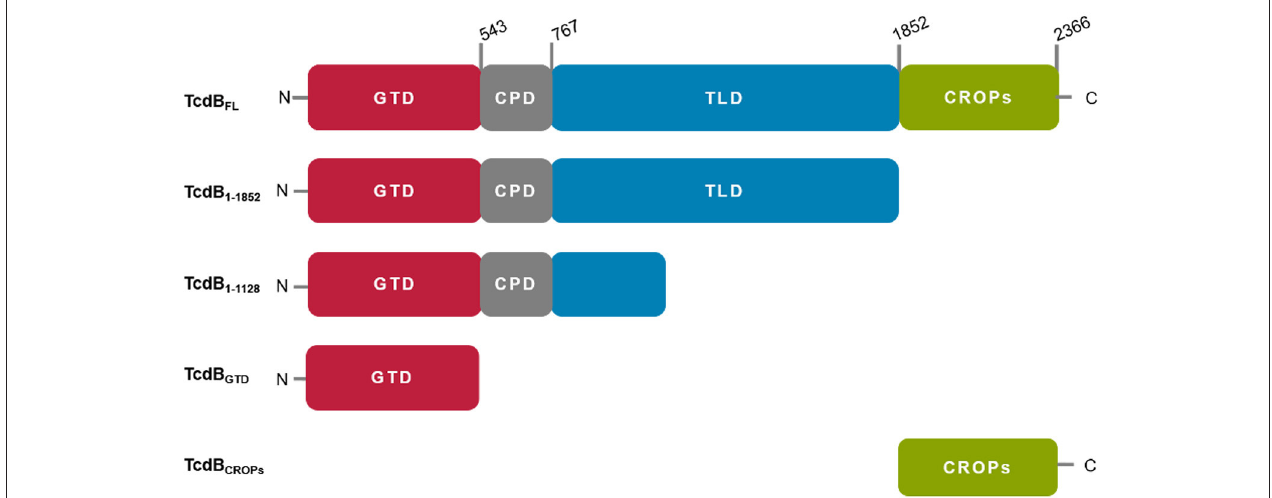
FIGURE 1 | Schematic representation of TcdB fragments used in this study. All fragments were derived from TcdB of C. difficile strain VPI10463. TcdB FL : wild type (wt) TcdB, TcdB 1 − 1852 : wt TcdB missing the CROP domain, TcdB 1 − 1128 : N-terminal 1128 aa of wt TcdB, TcdB GTD : enzymatically inactive mutant (D286/288N) of TcdB glucosyltransferase domain, TcdB CROPs combined repetitive oligopeptides, missing the first short